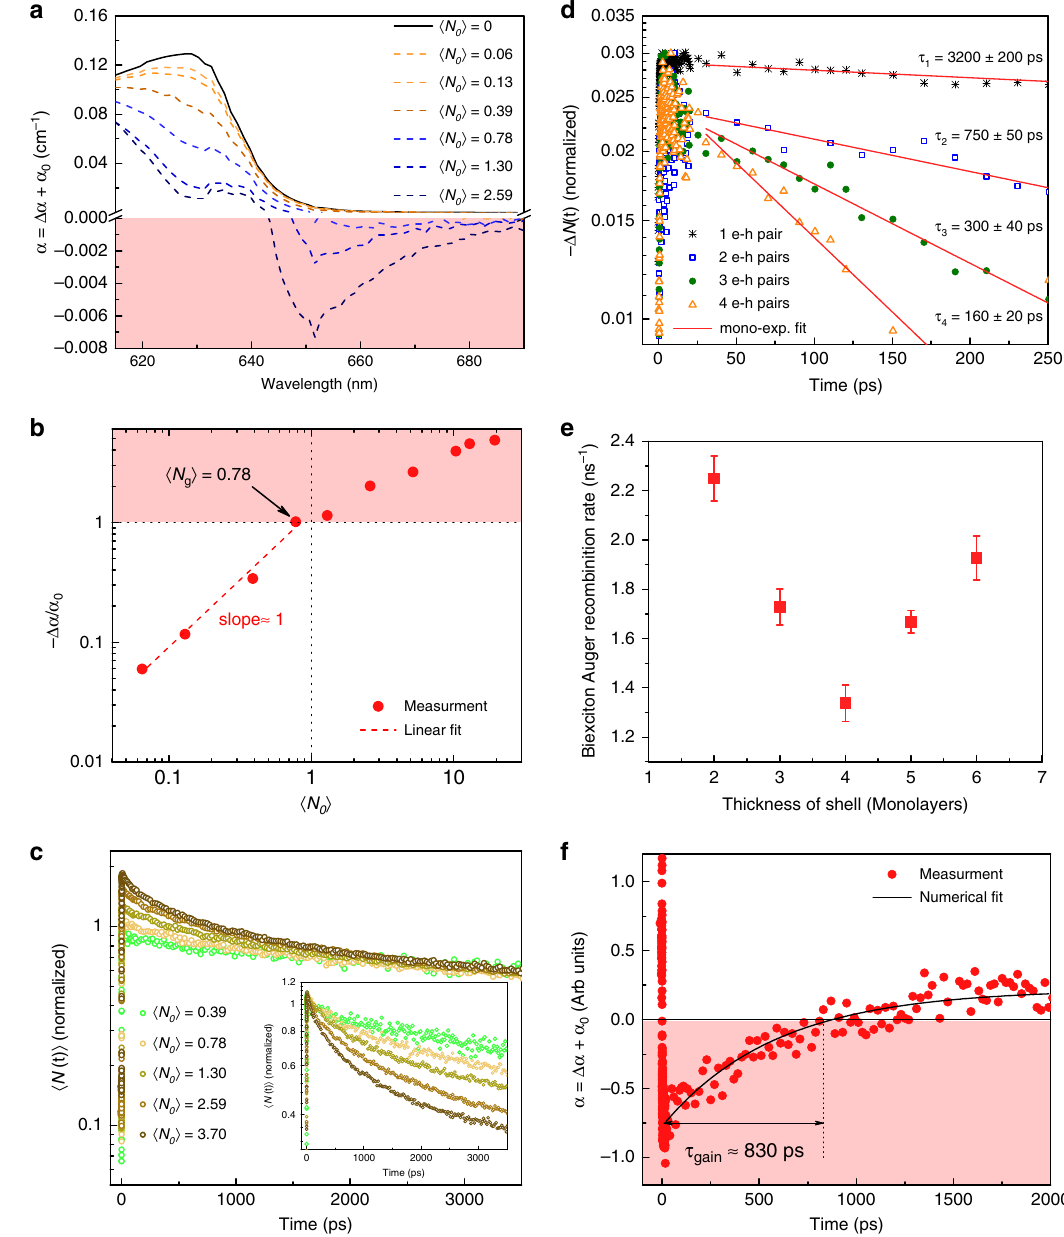
Fig. 2 Optical gain characterizations of the synthesized NPLs. a Nonlinear absorption ( α ) of 4- ML shell NPLs as a function of 〈 N o 〉 (from 0 to 2.59, N o is